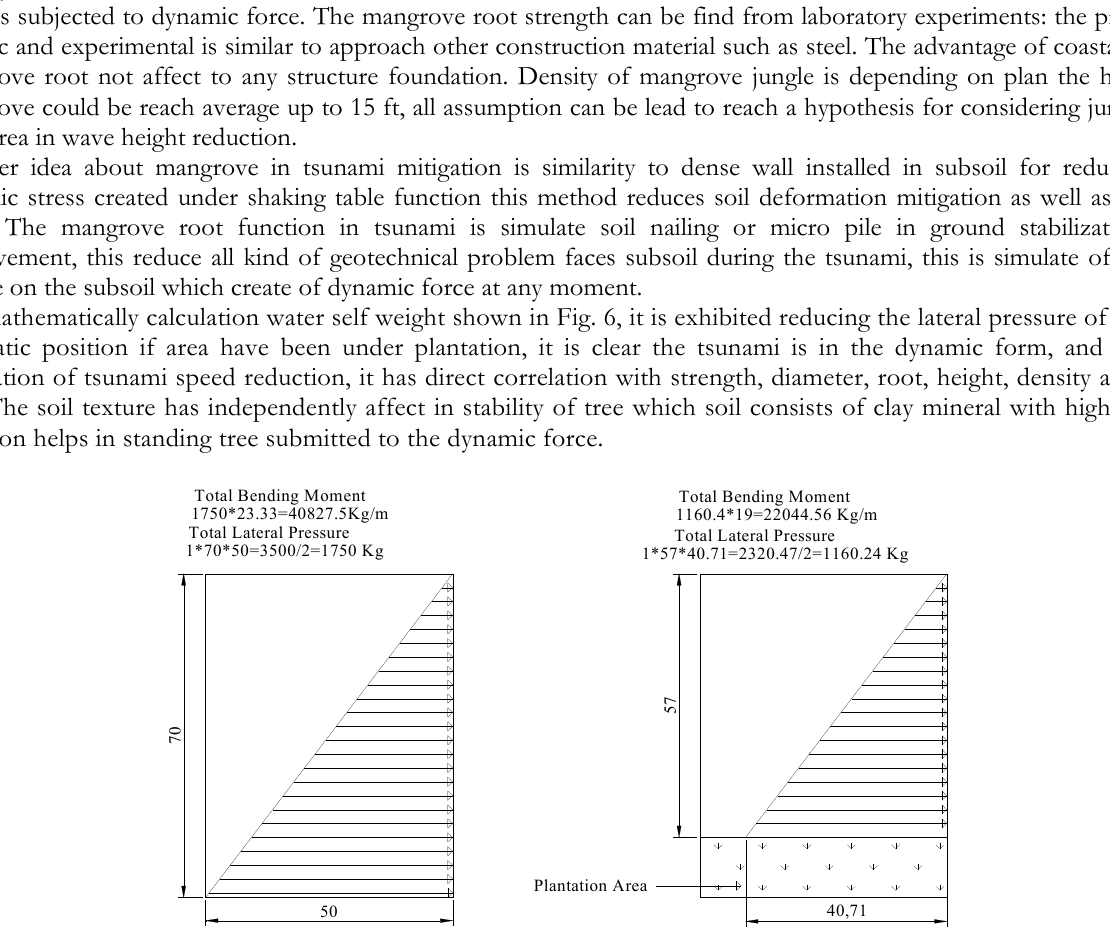
Figure 6: Water force model before and after plantation.